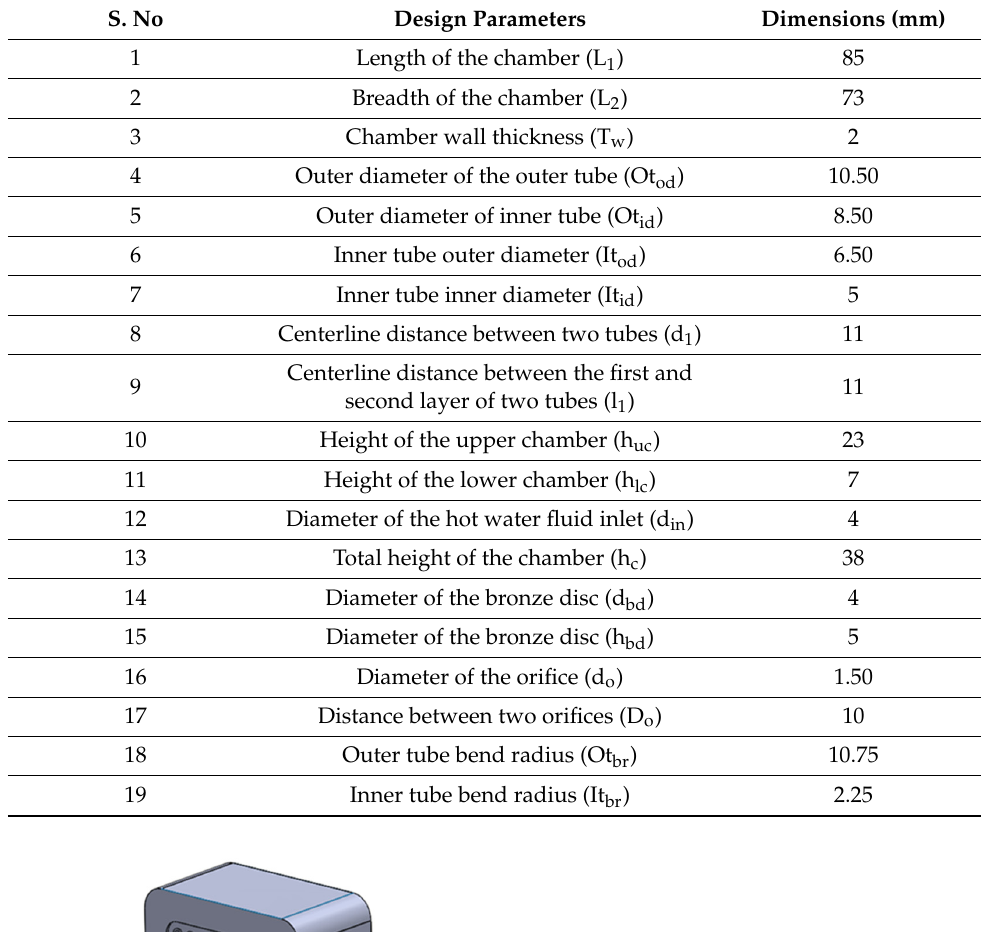
Table 2. Design parameters of the liver heat and mass exchanger device.